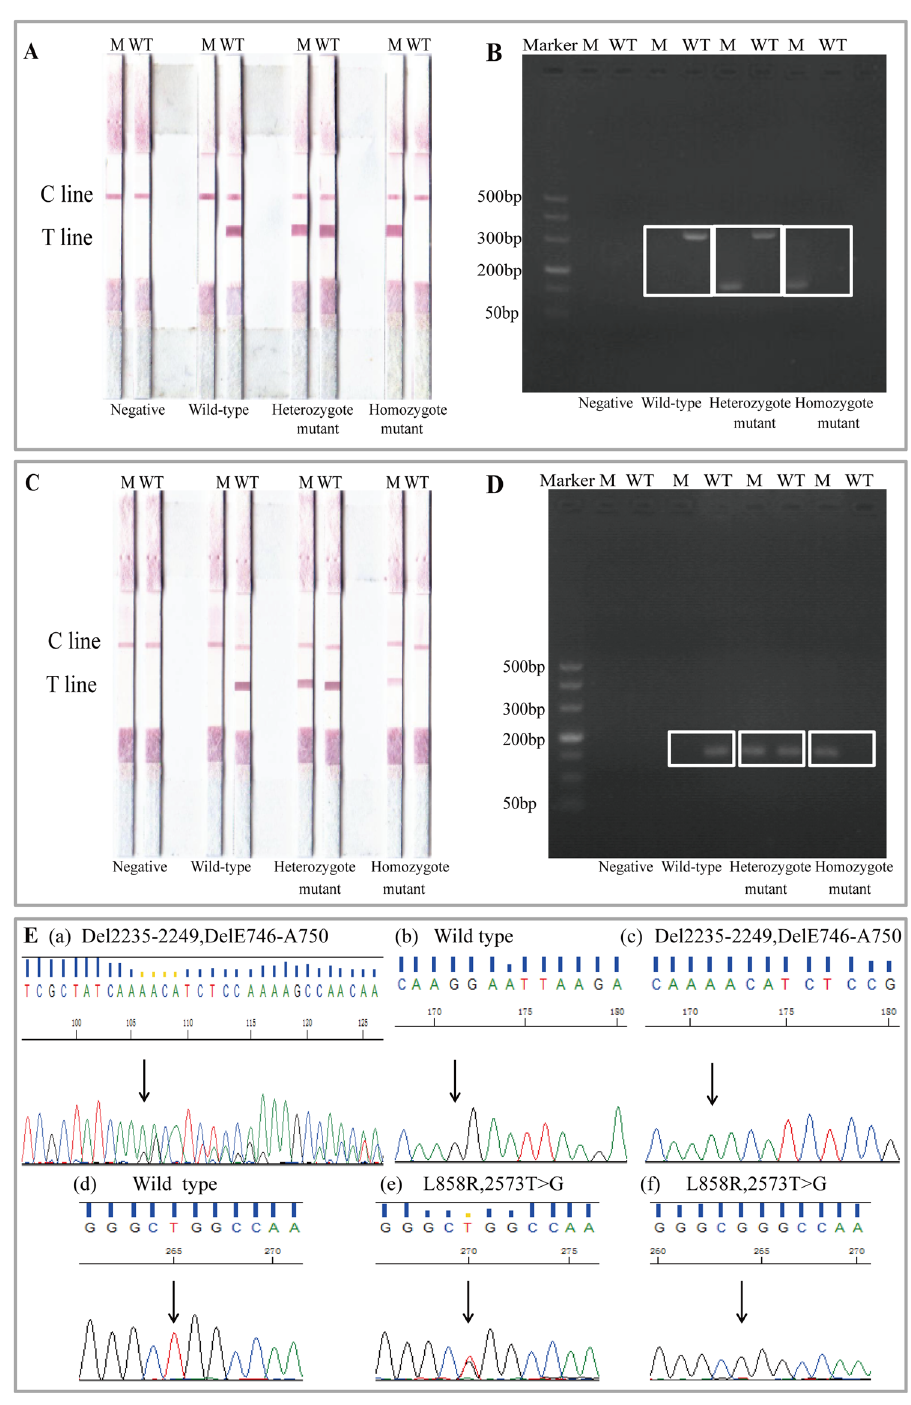
Figure 1. Evaluation of the specificity of E746-A750 and L858R detection using PCR-GoldMag LFAs. The test results of reference DNA samples (control DNA for wild type, cell line NCI-H-1650, NCI-H-1975 for heterozygous and plasmid containing delE746-A750, L858R for homozygous mutations) of E746-A750 ( A ) and L858R ( C ) by PCR-GoldMag LFA. (M = M tube. WT = WT tube.) Agarose gel electrophoresis results of E746-A750 ( B ) and L858R ( D ). (M = M tube. WT = WT tube.) ( E ) Sequencing results of E746-A750 and L858R. (a) 2235-2249del15bp detected in exon 19 from cell line NCI-H-1650. (b) Wild type of exon 19. (c) 2235-2249del15bp detected in exon 19 from plasmid. (d) Wild type sequence of L858R in exon 21. (e) 2573T > G detected in exon 21 in cell line NCI-H-1975. (f) 2573T > G detected in exon 21 in plasmid containing L858R homozygous